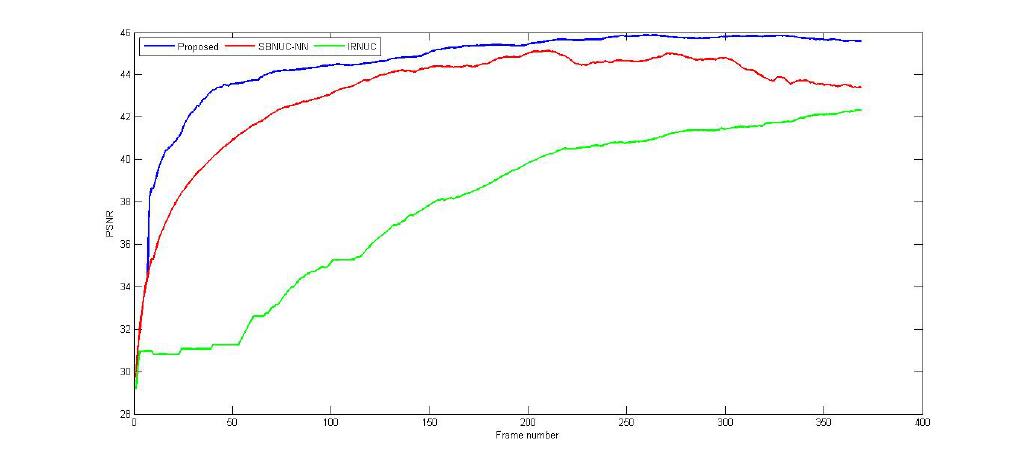
Figure 5. PSNR as a function of the frame number of sequence 1 for the three correction algorithms: proposed ( Blue ), adaptive ( Red ), registration-based ( Green